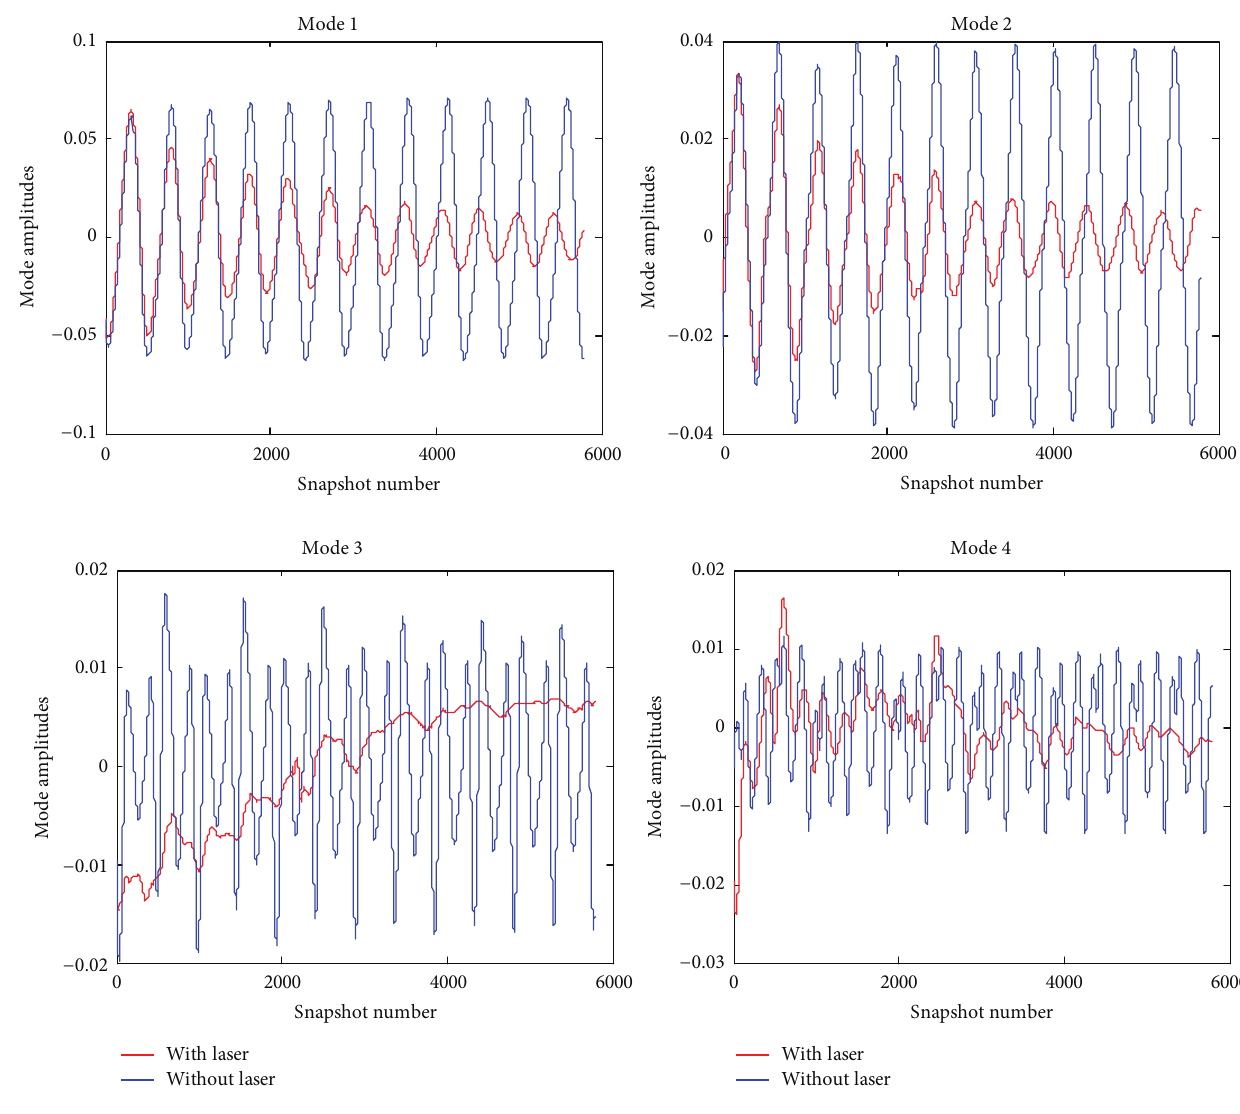
Figure 9: Time coefficient history of POD